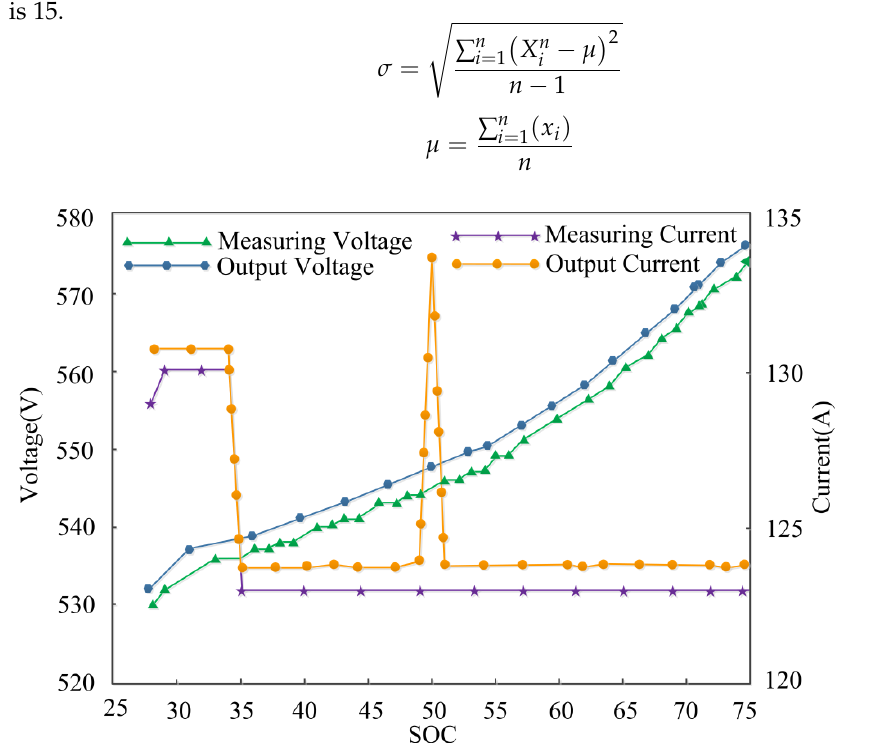
Figure 14. Curves of measured voltage, output voltage, measured current, and output current during the charging process of lithium battery EVs in an abnormal state.